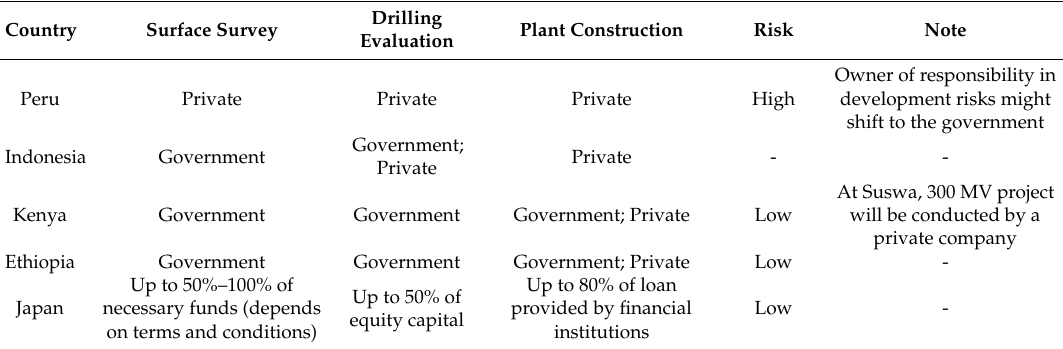
Table 1. Comparison of development stages in different countries